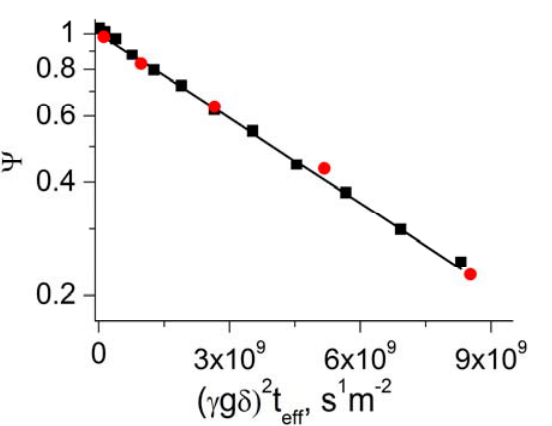
Figure 2. Examples of PFG NMR attenuation curves measured for methane diffusion in 6FDA/BPDA using proton ( ■ ) and carbon-13 ( ● ) PFG NMR. The measurements